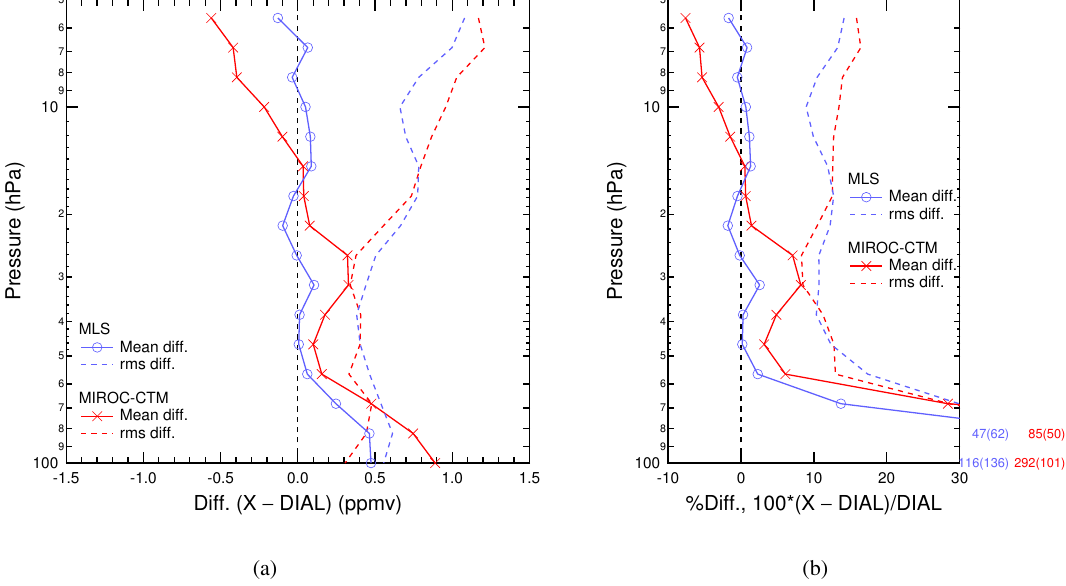
Figure 10. Vertical profiles of mean and rms differences of O 3 values for DIAL and X (MLS or MIROC-CTM) (a) and those of relative values (b) . Each value is computed from each pressure level in the time series as shown in Figs. 5 and 6. The numbers outside the plot are values of the mean (rms in parentheses) difference at 83 and 100hPa.